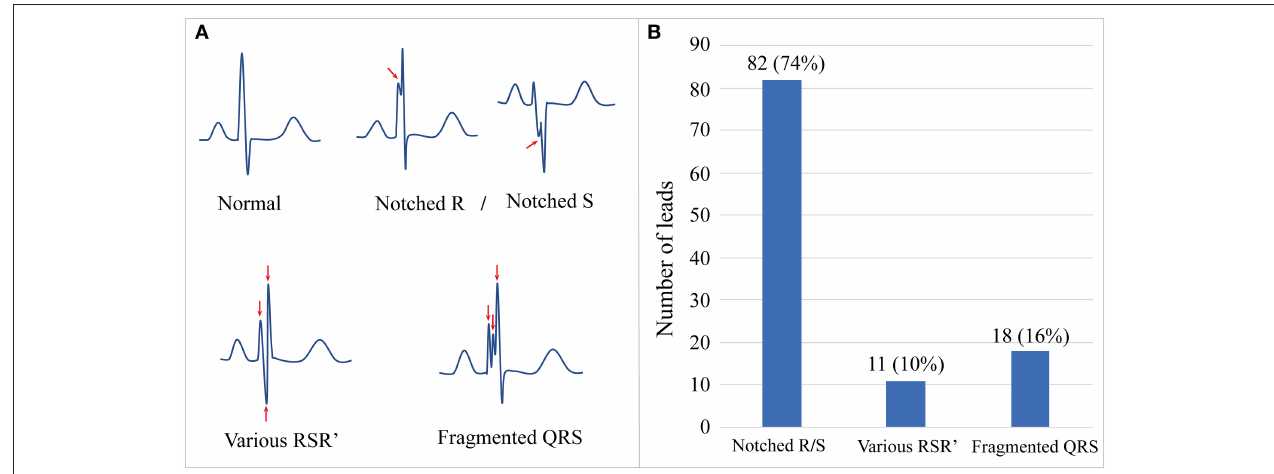
FIGURE 1 | The schematic diagram and prevalence of f-QRS complex in our Danon disease cohort. (A) Schematic diagrams show the normal morphology of QRS and different patterns of f-QRS complexes. (B) The number and proportion of three main patterns of f-QRS in our cohort. f-QRS, fragmented QRS.